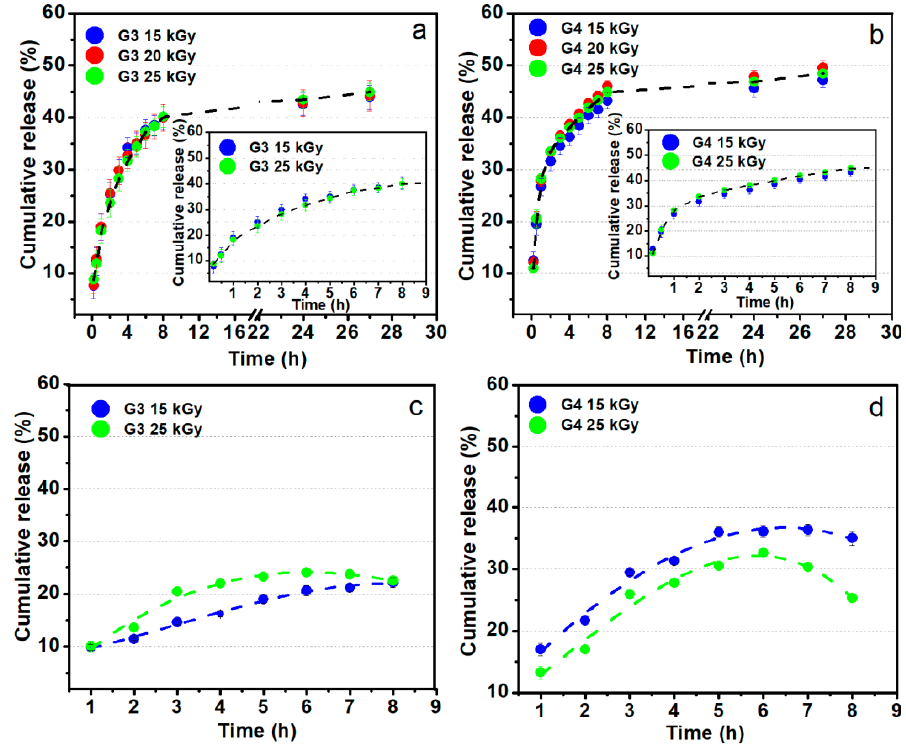
Figure 12. Ibuprofen release profiles from G3 and G4 hydrogels in PBS pH 7.4 ( a , b ) and sodium carbonate–sodium bicarbonate bu ff er pH 9.4 at 37 ◦ C ( c , d